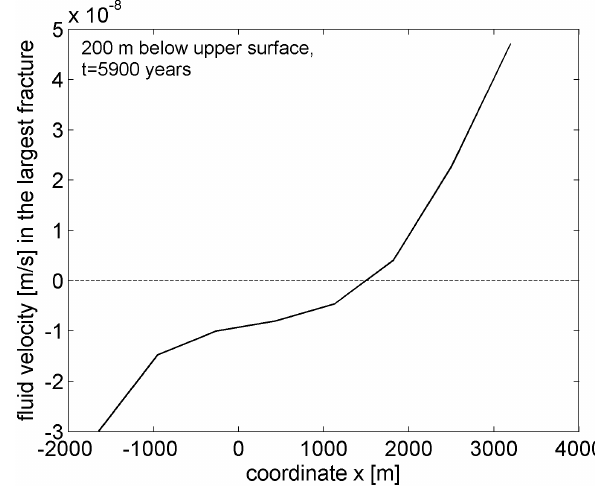
Figure 9. Vertical fluid velocity [ms − 1 ] in the intact part of the rock mass with fracture zones for the cross sections y = 6200 and − 3200m in the fractured and homogeneous regions, respectively, at a depth of 200m and at time 5900 years.